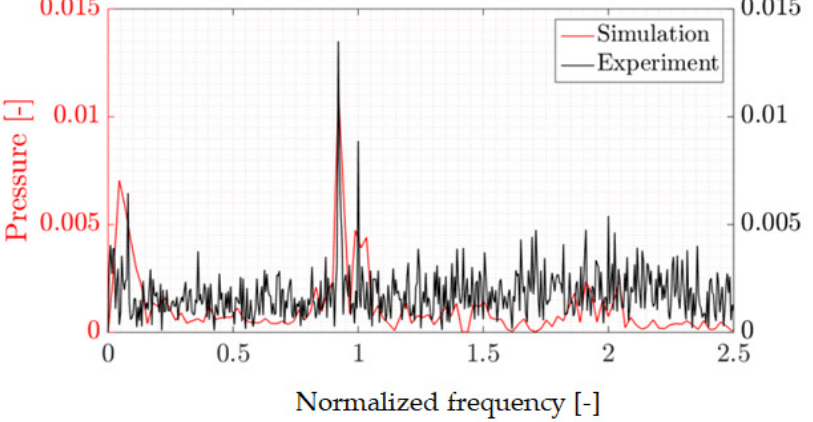
Figure 15. Amplitude spectrum of the pressure at P-SS-4 (suction side, center of the blade). Two vertical axes are used; numerical results—red, experimental results—black.